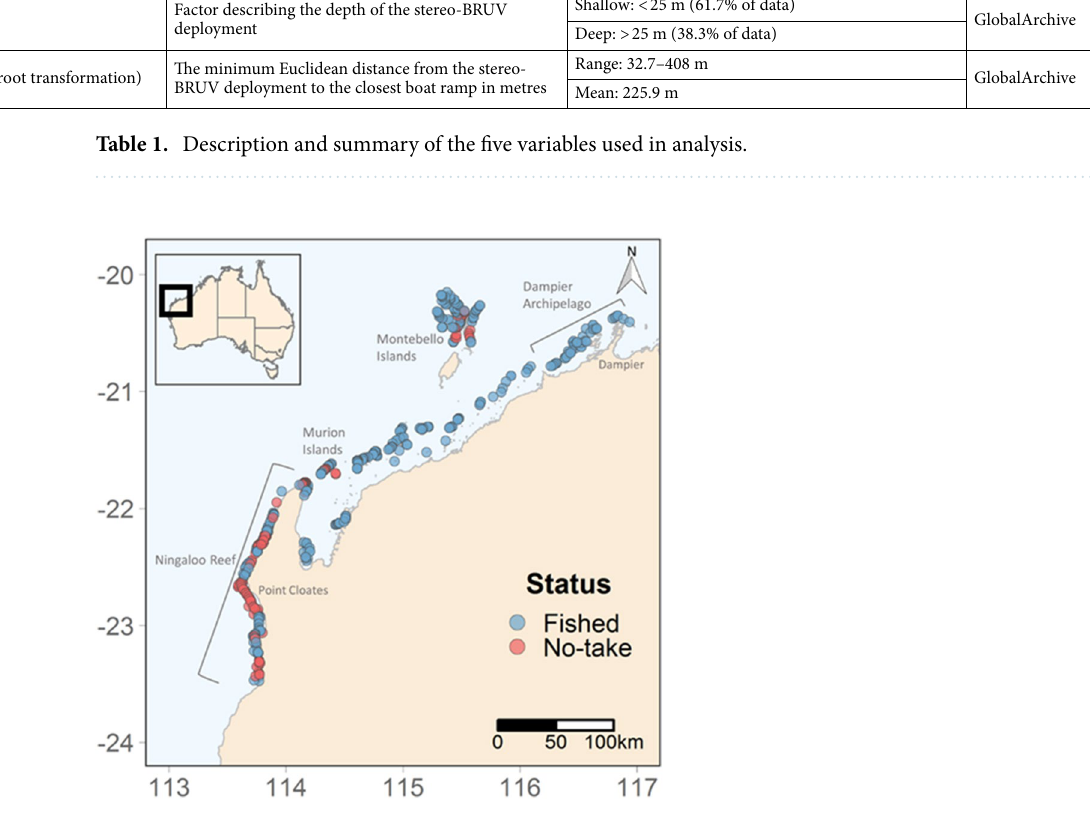
Figure 1. Map of BRUVs deployments in north-west Australia. Colour of circles indicates whether the BRUVs was deployed inside a No-Take Area (red) or in an area where fishing is permitted (Blue). Figure was generated using R 14 using ggplot2 15 and ggmap 16